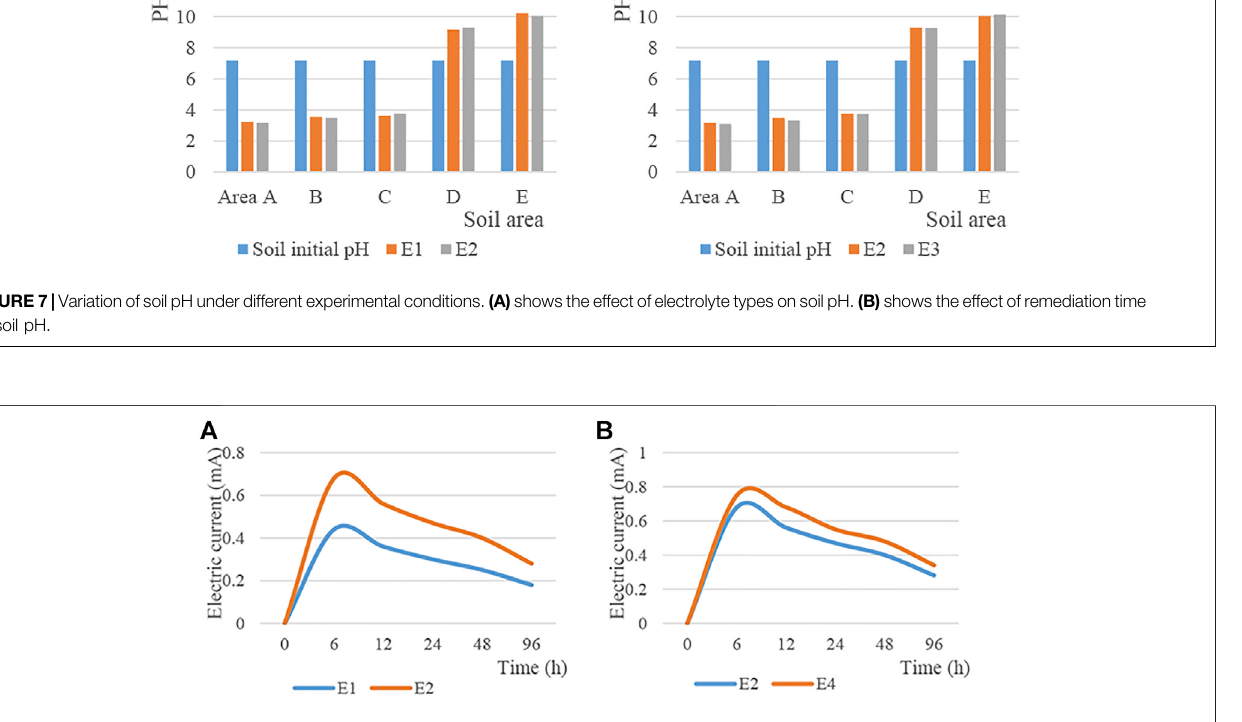
Figure 7 studies the effect of electrolyte type and remediation time on soil pH. Among them, the electrolyte of E1 is distilled water, the electrolyte of E2 is 0.1 mol/L KCl solution, the experimental voltage is 10V, and the soil remediation time is 24 h. As can be seen from Figure 7 , no matter whether the electrolyte is distilled water or KCl solution, there is no signi fi cant difference in the characteristics of soil pH change, all showing that the pH of the soil near the anode is lower, and the pH of the soil near the cathode is higher. In E2, the region A near the anode had a pH of 3.18, while the region E near the cathode had a pH of 10.05. And with the extension of remediation time, the soil pH in the anode area gradually decreased, and the pH values of area A in E2 and E3 were 3.18 and 3.09, respectively. The soil pH in the cathode area gradually increased, and the pH values of area E in E2 and E3 were 10.05 and 10.13, respectively. It is shown that the type of electrolyte has no obvious effect on the change of soil pH when the electrodynamic remediation device remediates the